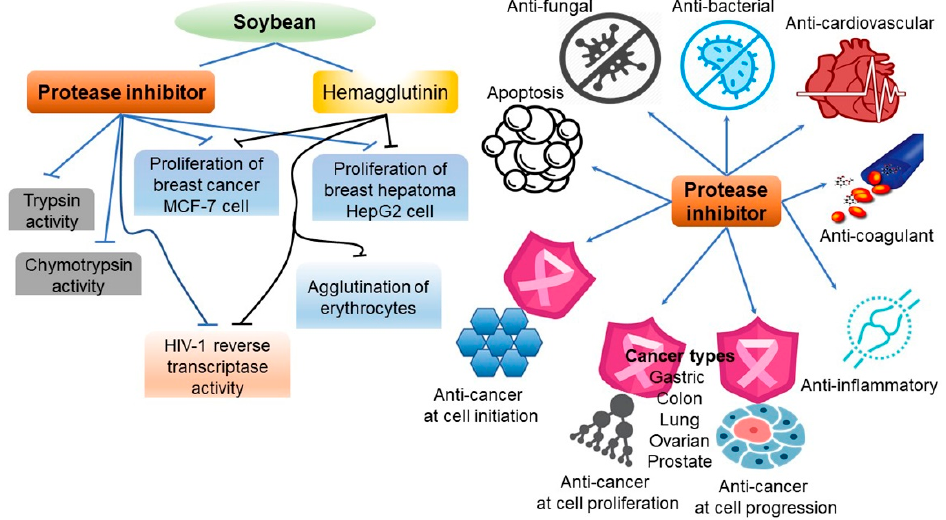
Figure 8. Biological activities of protease inhibitors ( left panel) and schematic representing major pharmacological activities of soybean ( right panel). Figure adapted from Srikanth, S. et al. [74].